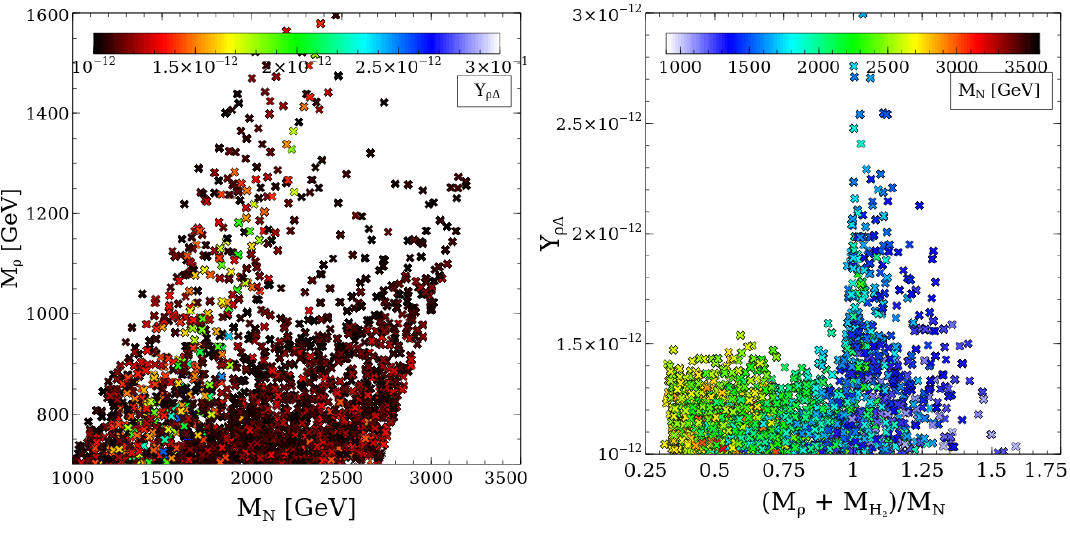
(cid:16) M (cid:17) plane where the color variation ρ + M H 2 − Y ρ ∆ M N ( M ). All the points in LP and RP satisfy BBN N ρ ∆